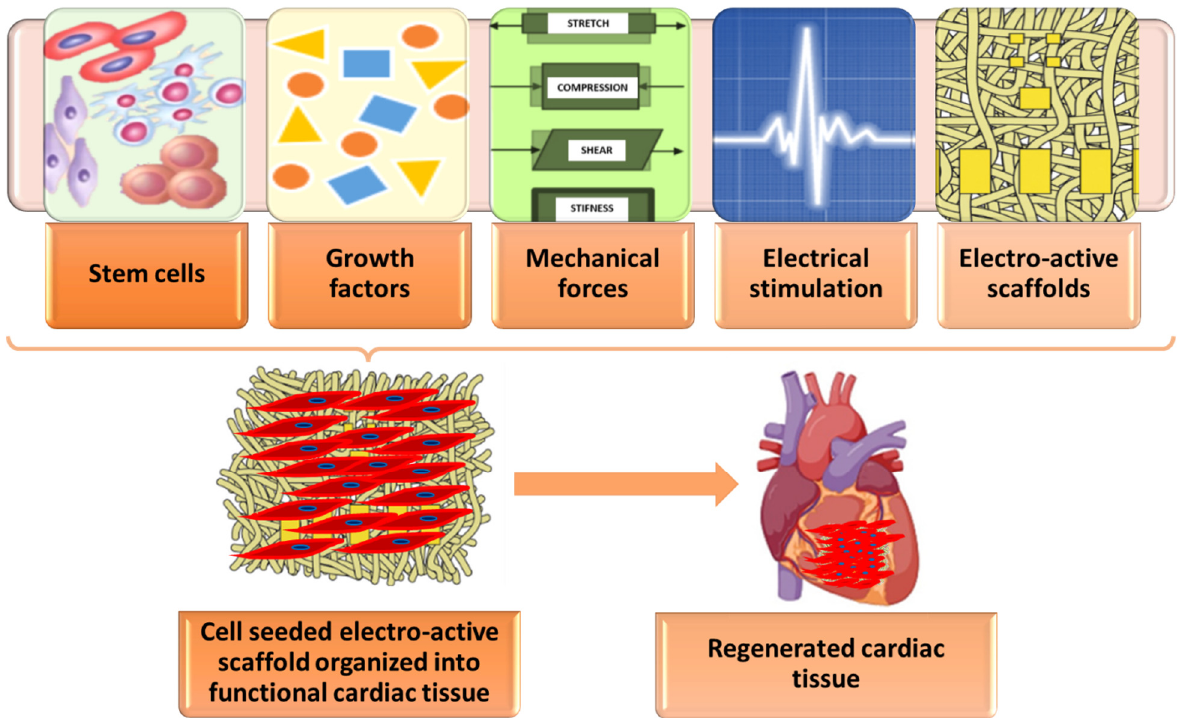
Figure 3. Overview of key factors for cardiac tissue regeneration. Created based on information from literature references [3,4,49] .